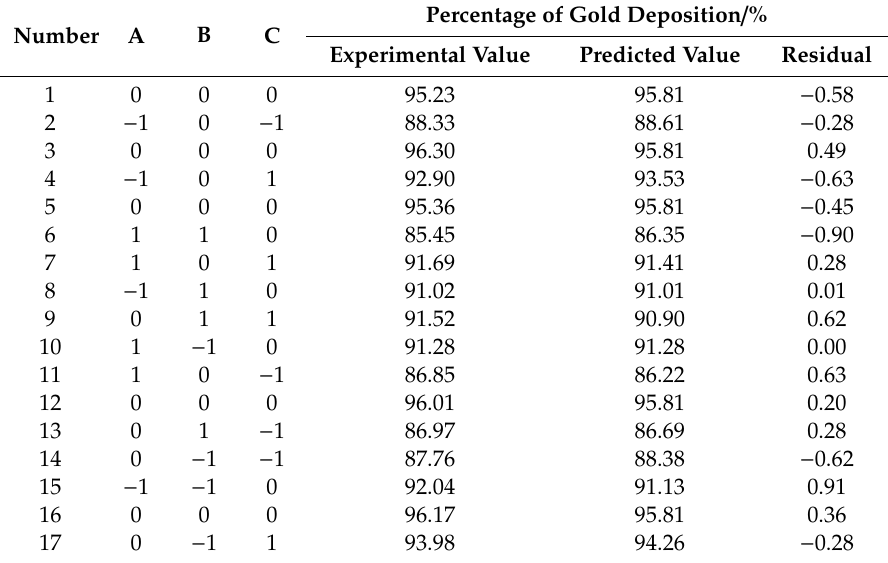
Table 2. Analytical schemes and test results for the response surface methodology.